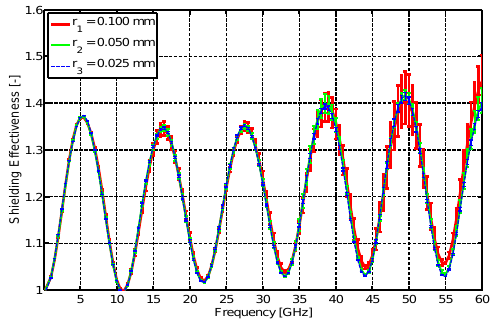
Figure 4: Effect of the sizes of the spherical inclusions on shielding effectiveness considering constant volumet- ric rate ν = 0 . 01 and variable radii: r 1 = 0 . 100 mm, r 2 = 0 . 050 mm, and r 3 = 0 . 025